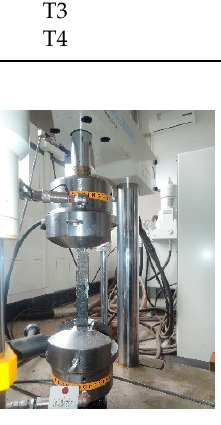
Table 2. List of test specimens.